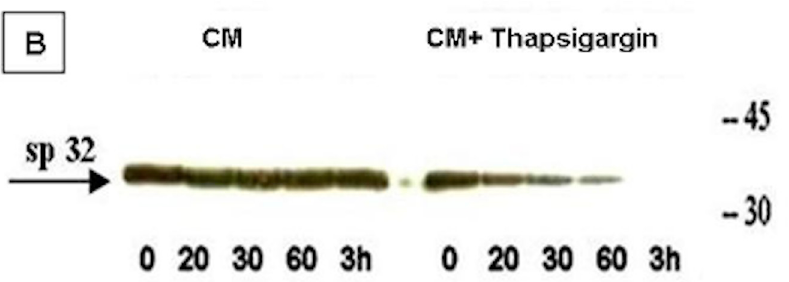
Fig 3. Western blots of sperm proteins incubated in capacitation medium with or without thapsigargin probed with anti-ACRBP antibodies. Washed boar sperm were incubated for 0, 20, 30, 60 and 180 minutes in capacitation medium with or without thapsigargin. The blot represents results from three